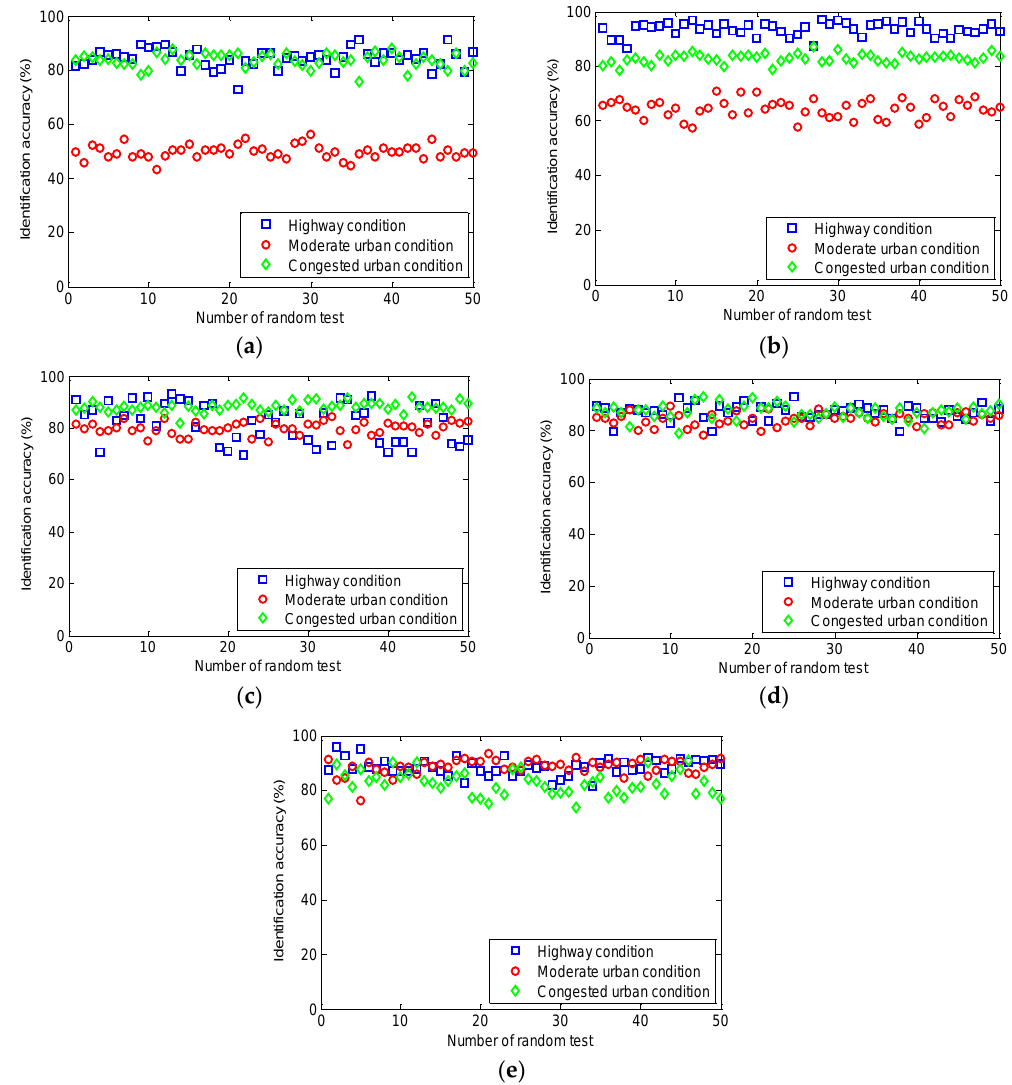
Figure 18. Identification accuracy based on different length ranges of slide time window. ( a ) Identification accuracy with 50 s; ( b ) Identification accuracy with 100 s; ( c ) Identification accuracy with 150 s ( d ) Identification accuracy with 200 s; ( e ) Identification accuracy with 250 s.